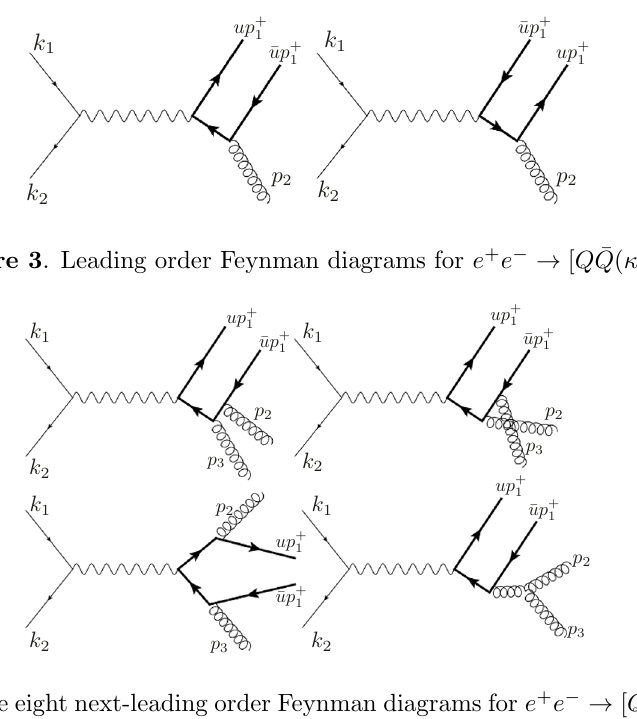
[ Q (cid:22) Q ( (cid:20) )] gg at ( (cid:11) 2 ). s ! O